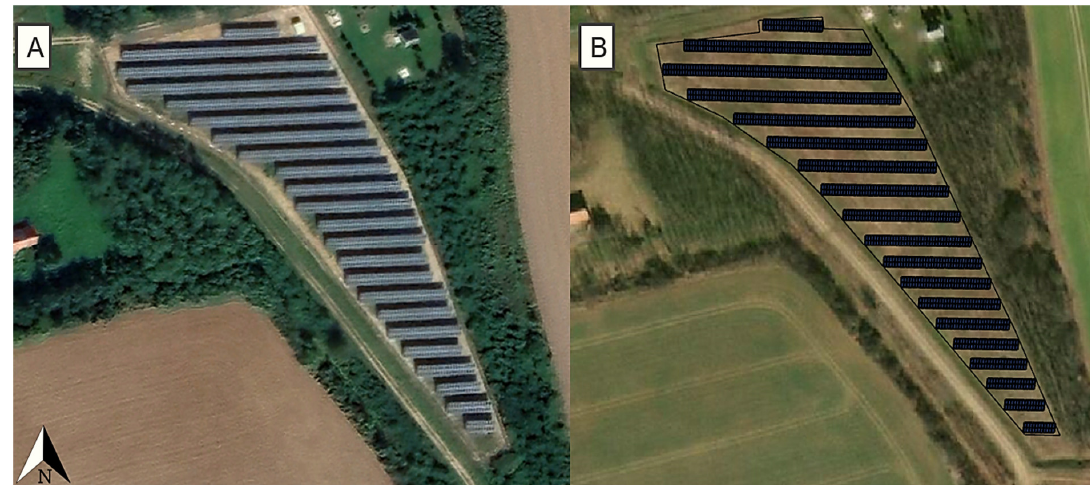
Figure 7. The layouts of the actual ( A ) and the modelled ( B ) PV power plants with equal capacities of 0.5 MW in Kiskölked, Rádóckölked, based on [41,54,55].